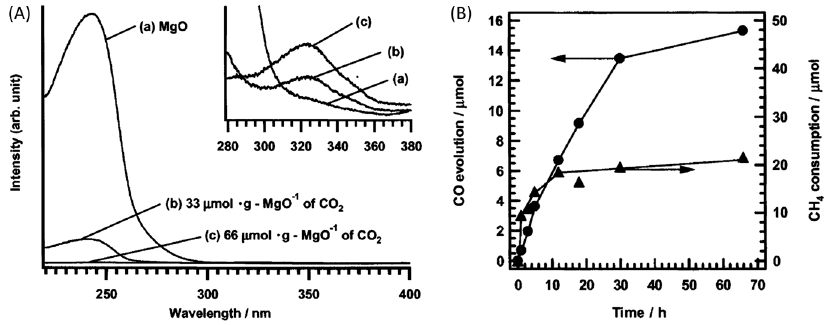
Figure 20. ( A ) Phosphorescence exciting spectra of MgO. ( B ) Time course of the CO yield and CH 4 consumption over MgO. Reprinted with permission from [44]. Copyright (2004), American Chemical Society.